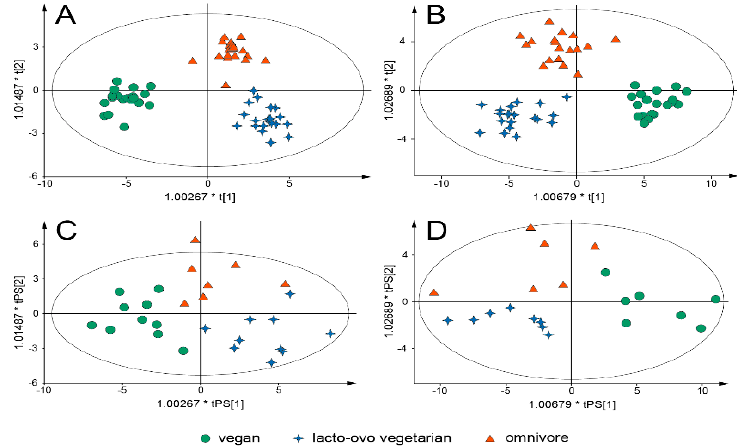
Figure 1. Orthogonal (2) projections to latent structures with discriminant analysis (O2PLS-DA) models of metabolic profiles from vegan, lacto-ovo vegetarian, and omnivore breakfasts. ( A , B ) display the distribution of metabolic profiles in O2PLS-DA models and ( C , D ) denote samples predicted onto the models. ( A ) ( n = 60) and ( C ) ( n = 27) are based on postpandial (3 h) samples. ( B ) ( n = 57) and ( D ) ( n = 21) plots are based on an effect matrix where the metabolic profiles have been calculated from the difference between fasting and postprandial state. * The scores are scaled proportionally to their R 2 X values. Both models included 196 variables.